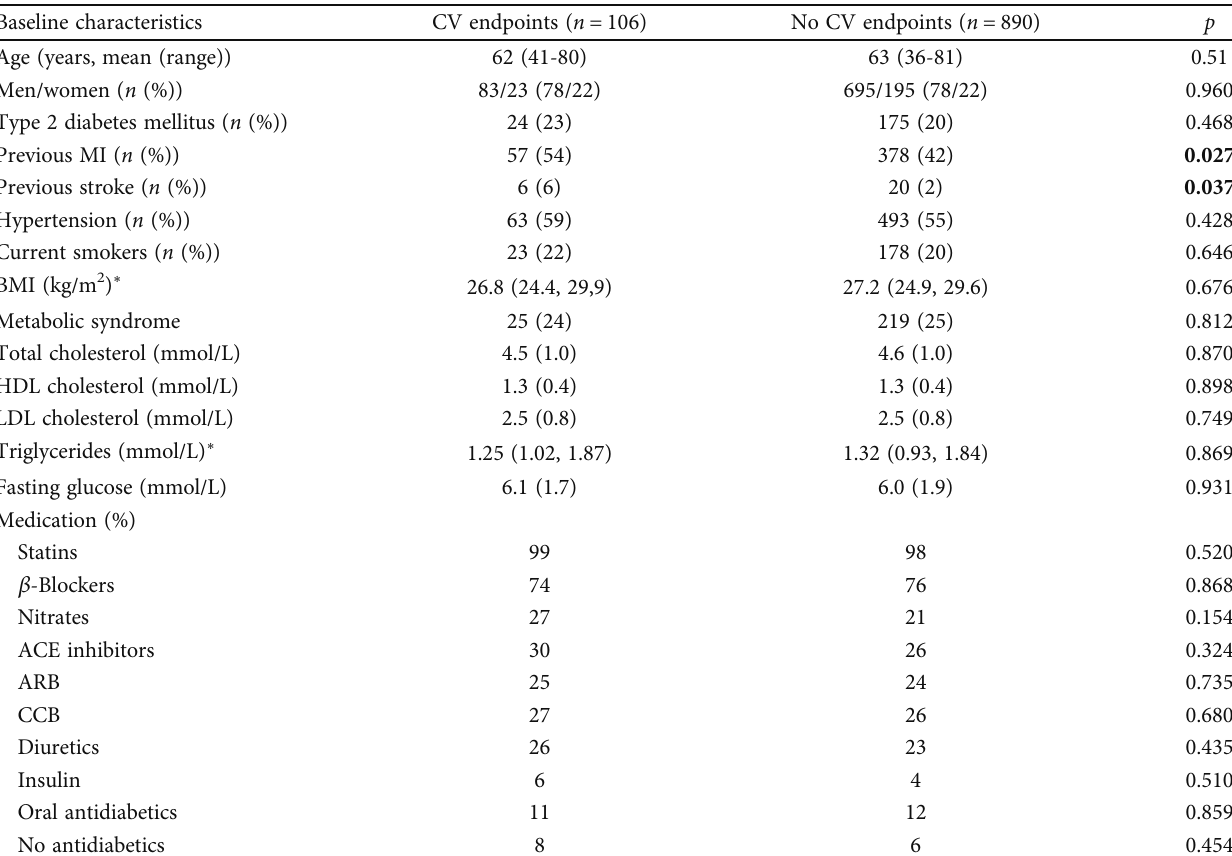
Table 1: Baseline characteristics in the population ( n = 996 ) according to occurrence of composite clinical endpoint during two years. Baseline